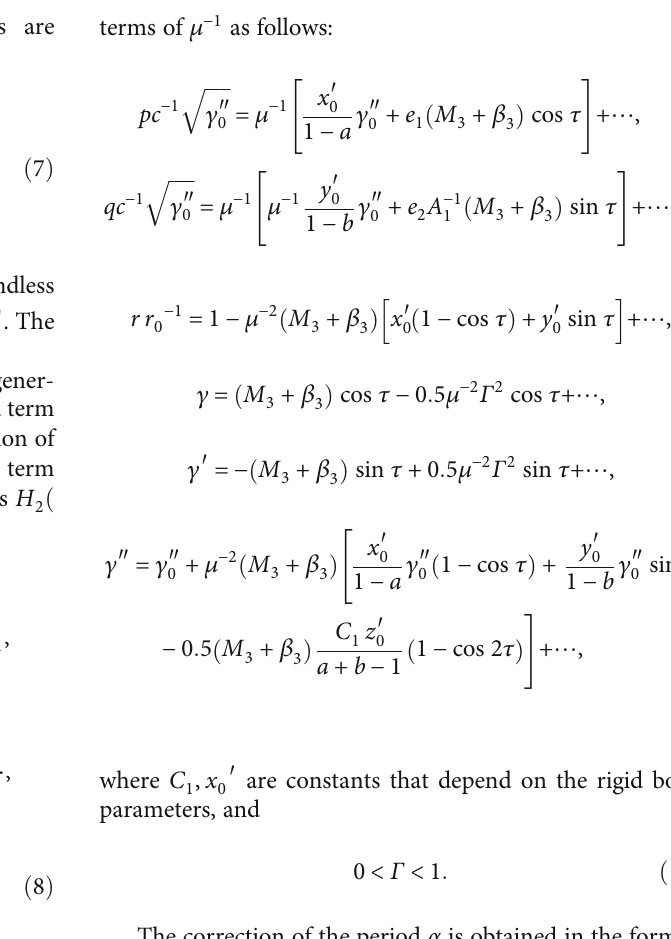
1 against the time t